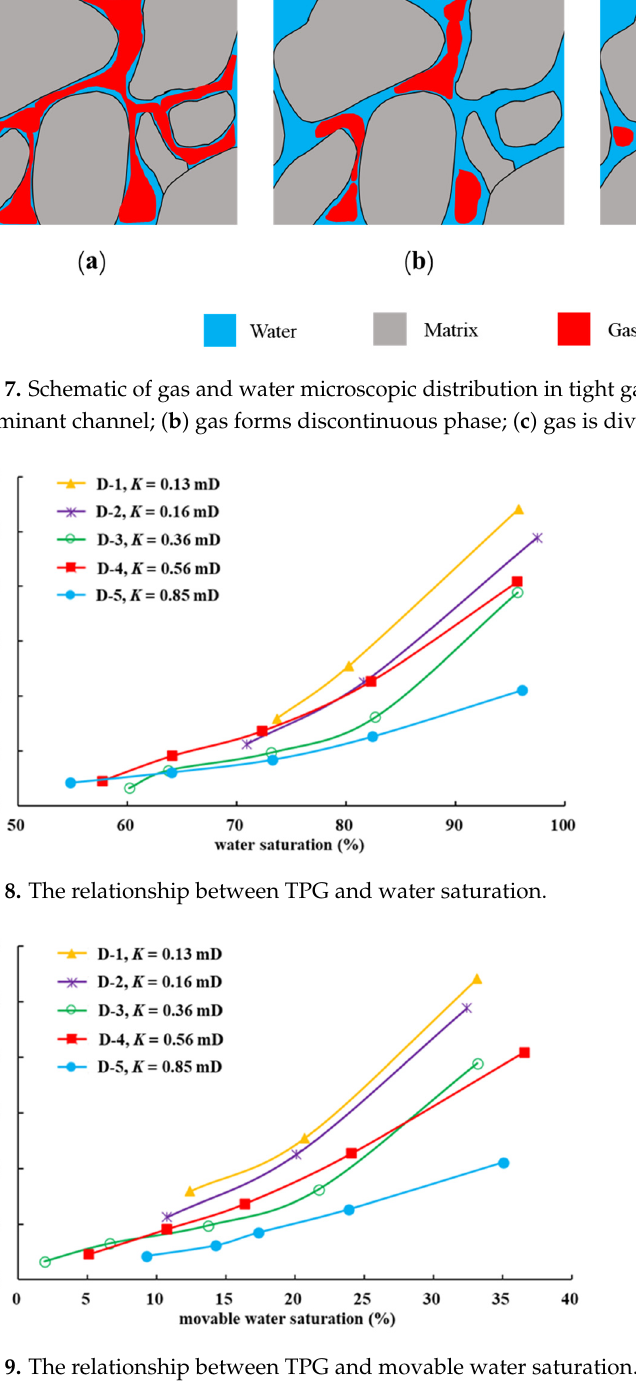
Table 5. The fitting formulas between TPG and S wm